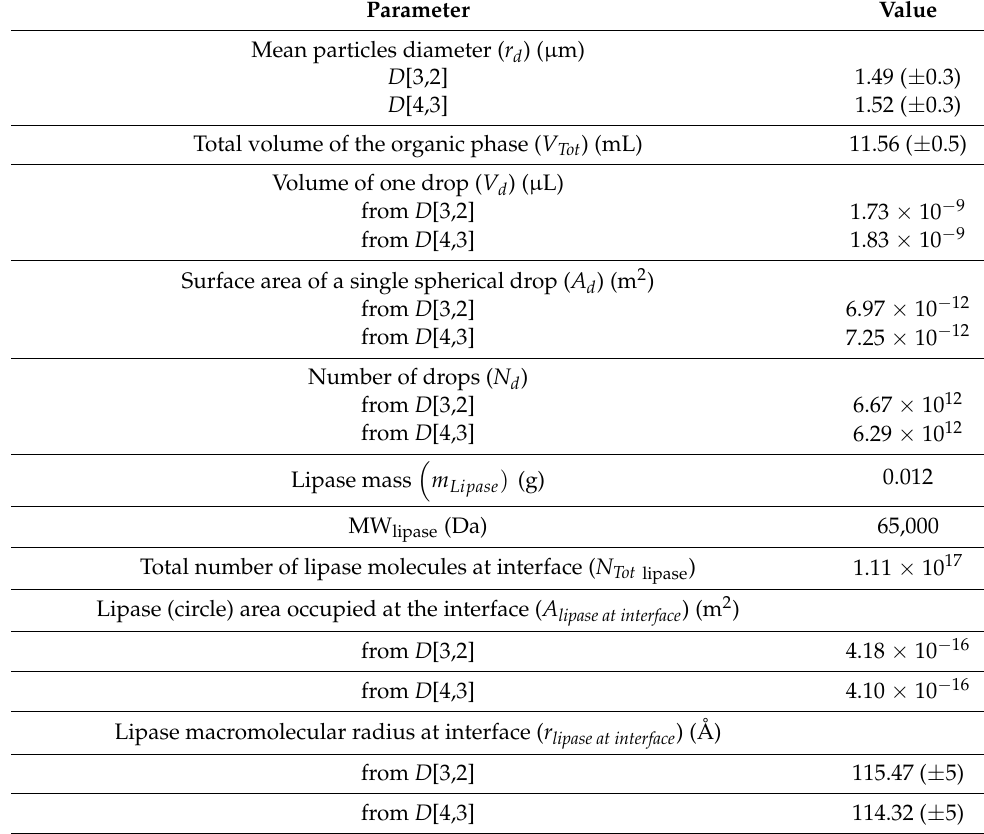
Table 3. Parameters used to calculate lipase hydrodynamic diameter at the